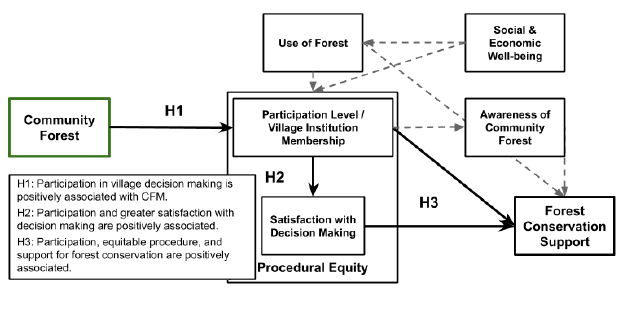
Fig. 1 . Model conceptualization of simple theory of change for community-based forest management (CFM), connecting participation, procedural equity, and conservation support (solid arrows). Other factors that arise in the literature, including forest use and socioeconomic well-being are included with dashed arrows, denoting their hypothesized relationships with procedure and forest